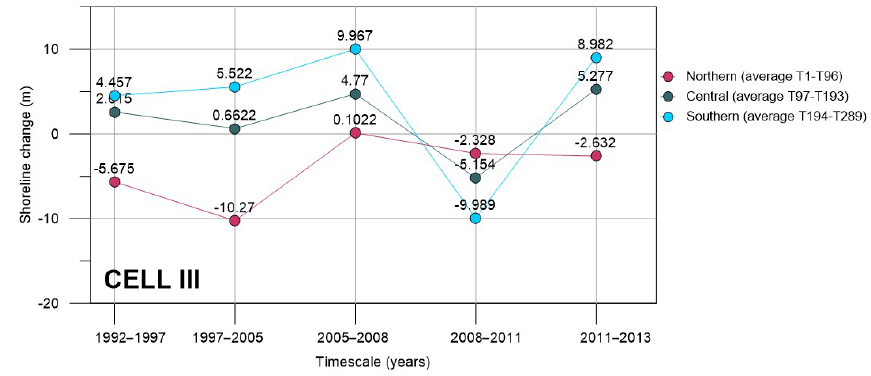
Figure 12. Average shoreline position in the northern, central and southern sectors of Cell III. Table 1. Pearson’s correlation matrix applied to Cell I. Note: red marks positive relationships between profiles and blue marks negative relationships. Italic indicates p < 0 . 05.